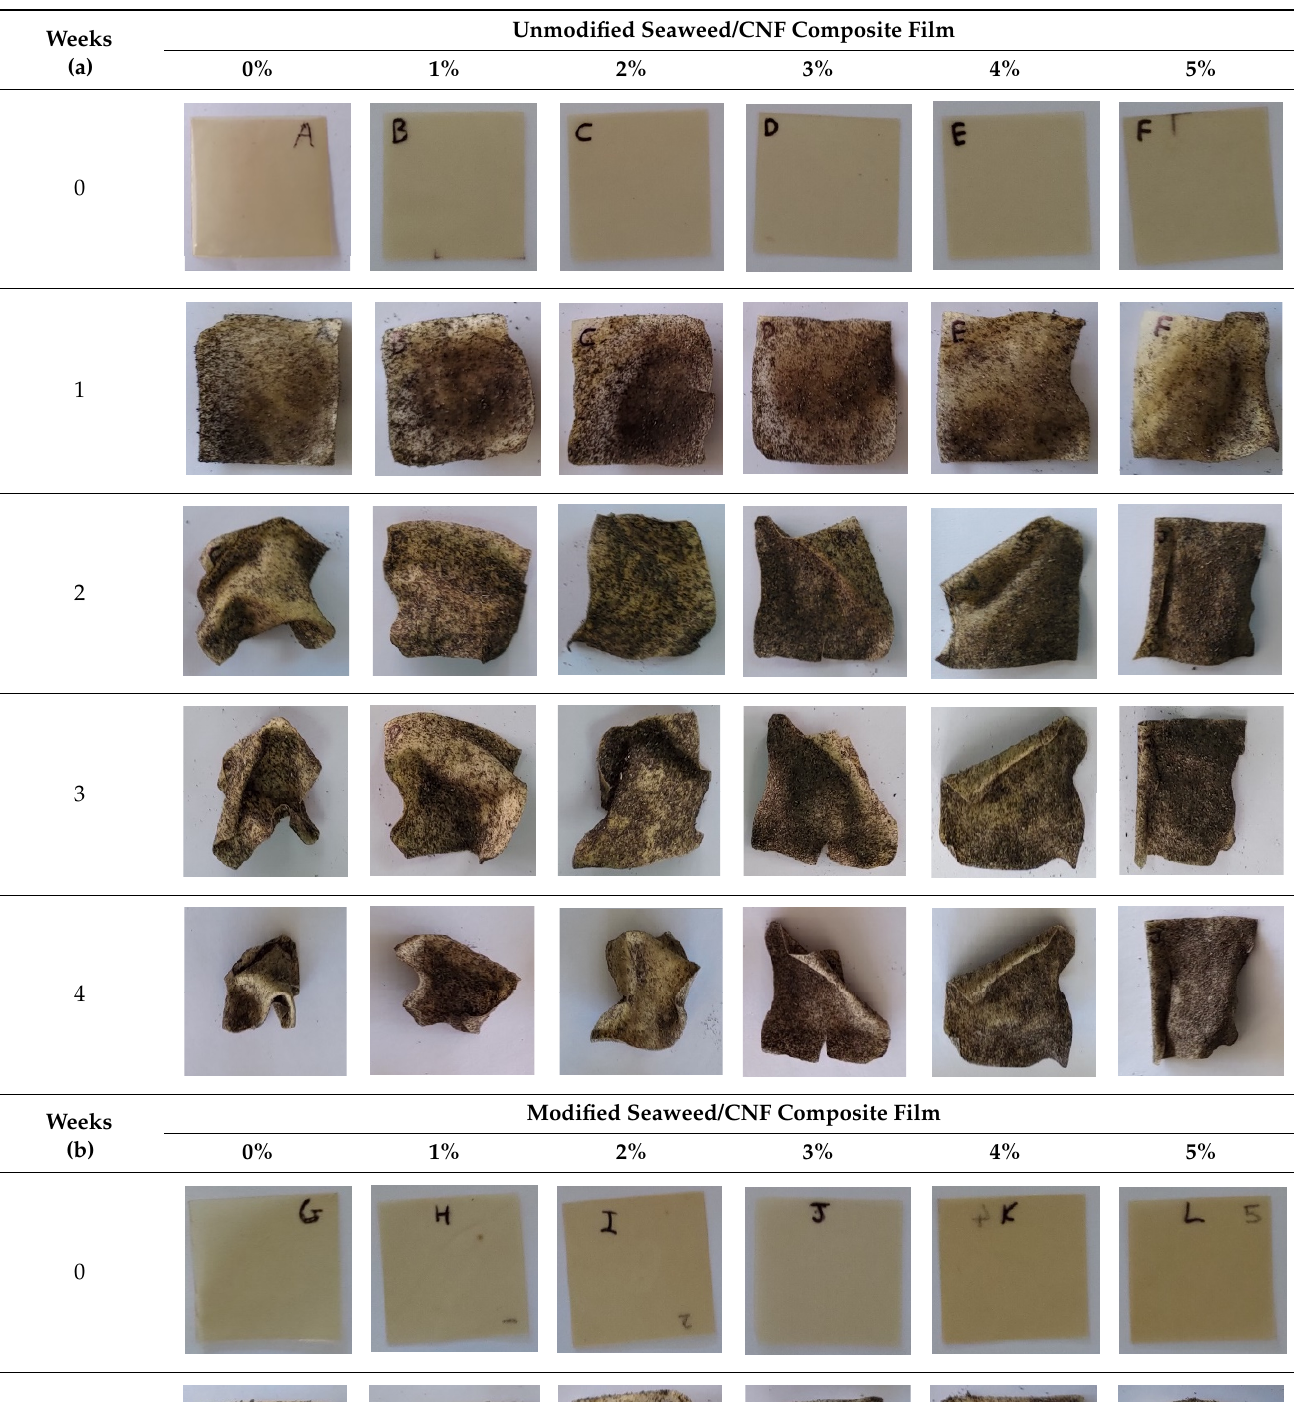
Table 2. Soil burial degradation of unmodified (a) and modified (b) seaweed/CNF composite film. Weeks